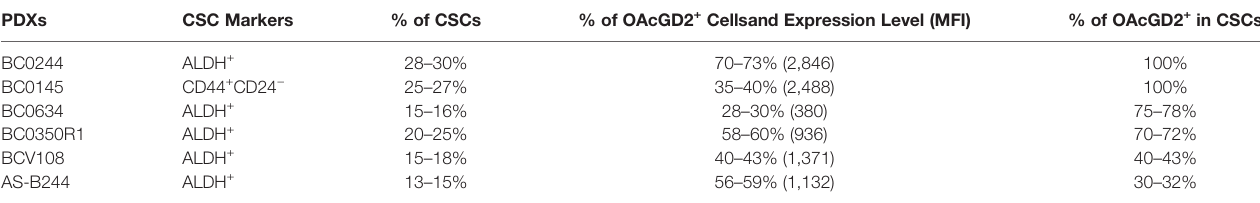
TABLE 1 | Expression of OAcGD2 in PDXs of breast